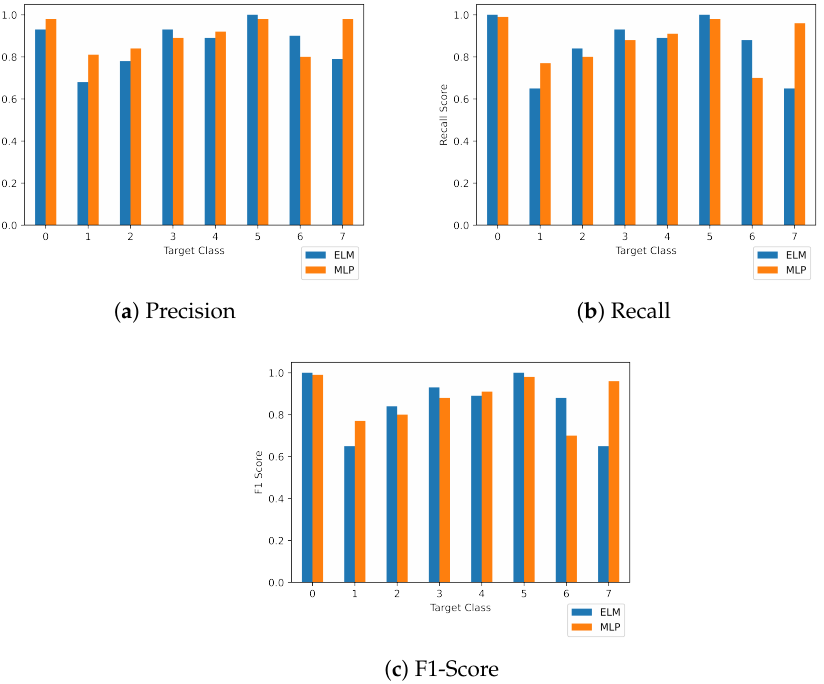
Figure 13. Comparison of accuracy metrics for MLP and ELM for each target class in the dataset. Table 5. Intra-class summary of ELM performance on testing data.